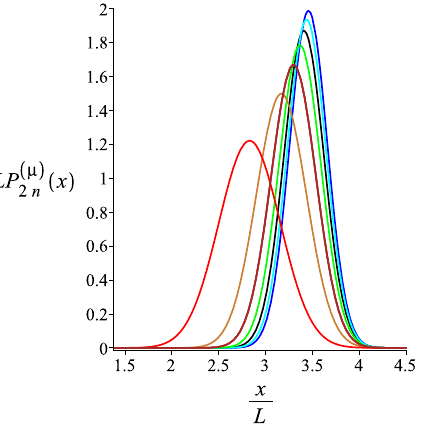
Figure 7. The probability density of the x component of the position of the free endpoint of the grafted structure with an even number of arms. The red, gold, brown, green, black, cyan, and blue are associated with the fixed values of the magnetic interaction parameter, K B = 0,3,6,9,12,15,18, respectively. The other fixed parameters are: ω = π